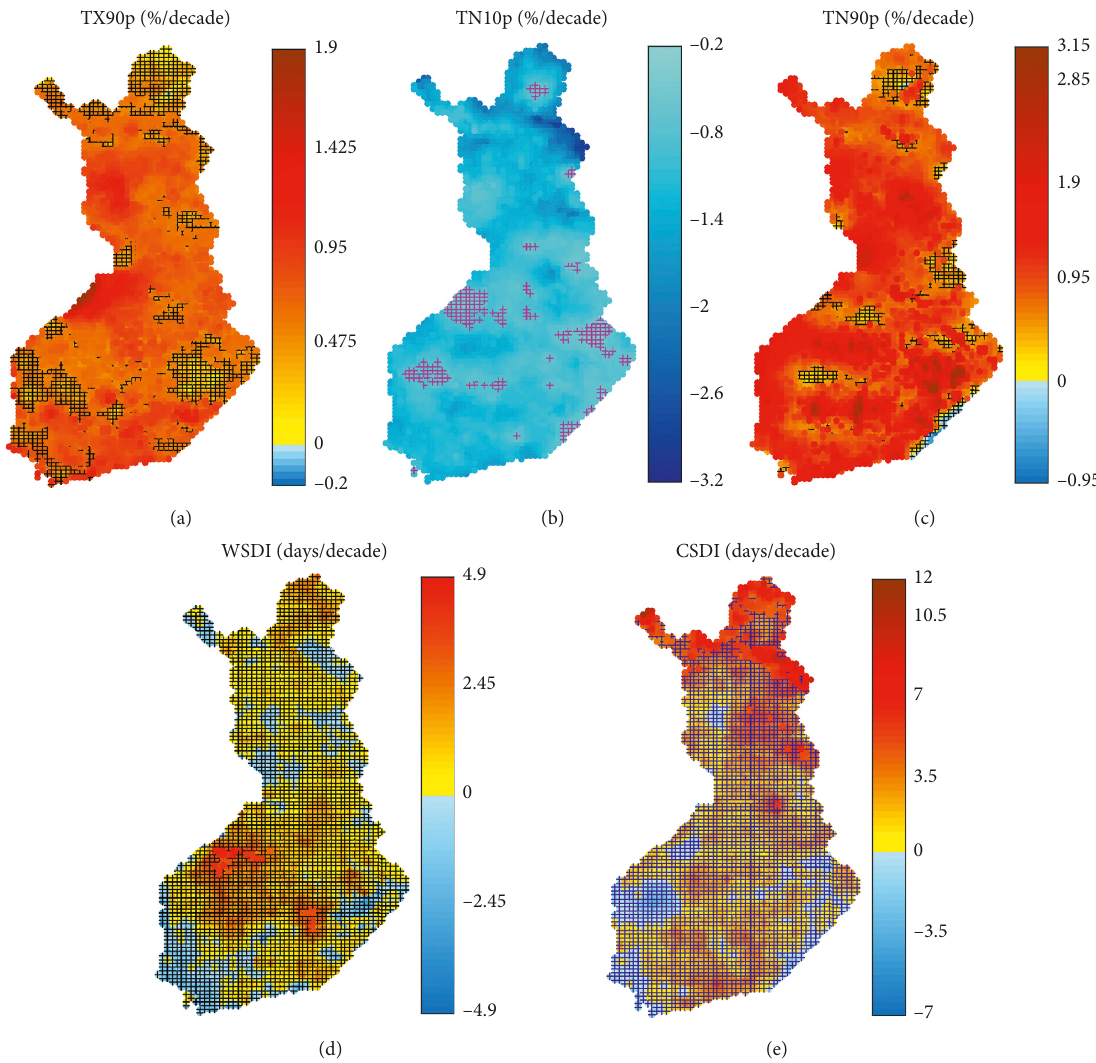
Figure 8: Spatial distribution maps of trends (/decade) in (a) TX90p, (b) TN10p, (c) TN90p, (d) WSDI, and (e) CSDI in Finland during 1961–2011. The stippling indicates areas where the trends are statistically insignificant ( p